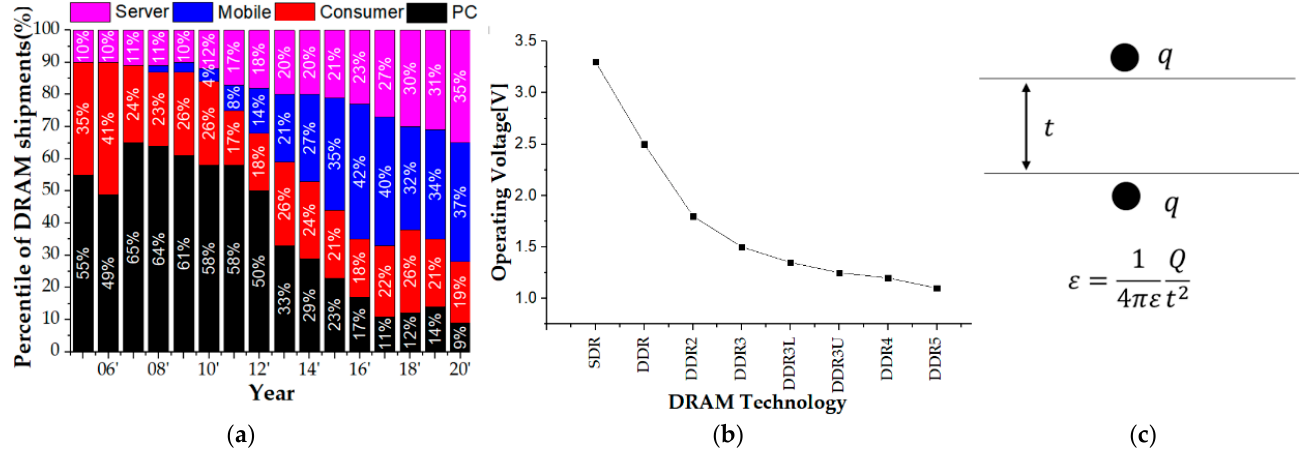
Figure 1. ( a ) Changes in DRAM market demand, ( b ) DRAM operating voltage history, and ( c ) electric field equation between two charges.